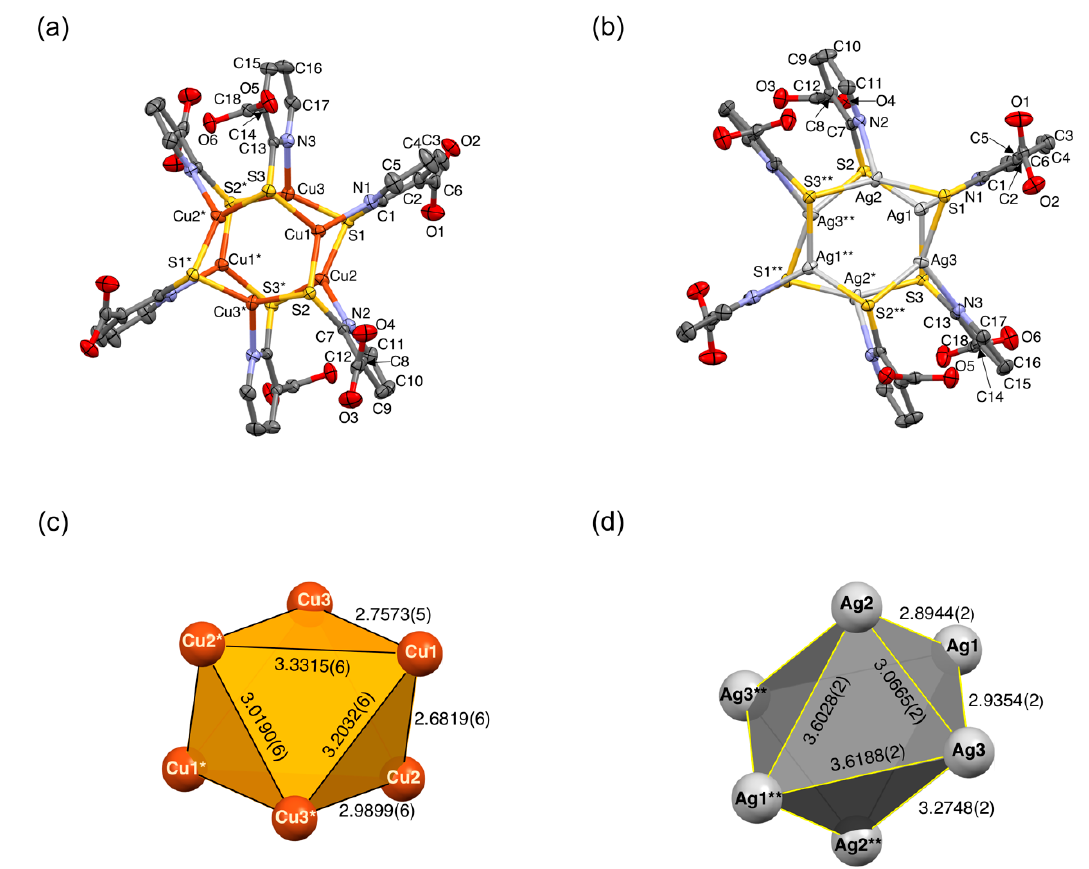
Figure 2. ORTEP drawings of the molecular structures of ( a ) 1 · 7DMF and ( b ) 2 · 8DMSO at 150 K. Thermal ellipsoids are drawn for non-hydrogen atoms at a 50% probability level. Solvated molecules are omitted for clarity. Octahedral metal cores of ( c ) 1 and ( d ) 2 with intermetallic distances in Å projected along the − 3 axis of the virtual molecular symmetry. Atoms labeled with asterisks (* or **) are related to their original atoms by a crystallographic inversion center located in the middle of the molecule.